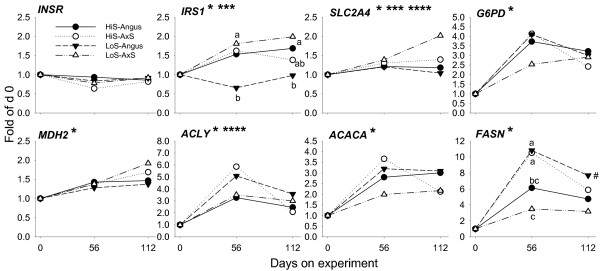
mRNA expression patterns of genes associated with insulin signaling (INSR, IRS1), insulin-stimulated glucose uptake (SLC2A4), cytosolic NADPH generation (G6PD), malate-aspartate shuttle (MDH2), cytosolic acetyl-CoA synthesis from citrate (ACLY), and de novo fatty acid synthesis (ACACA, FASN) in Angus or A × S steers (n = 6/type) fed a high-starch (HiS, n = 3/type) or low-starch (LoS, n = 3/type) diet. Fold-change expression during the growing phase is expressed relative to day 0. Pooled SEM: INSR, 0.1; IRS1, 0.2; SLC2A4, 0.2; G6PD, 0.6; MDH2, 0.2; ACLY, 0.7; ACACA, 0.5; FASN, 1.2. Asterisks denote (P < 0.05): *Time effect; **Diet effect; ***Steer type effect; ****Tendency (P < 0.13) for diet × steer type × day interaction. IRS1 and FASN had (P < 0.05) a diet × steer type interaction. FASN had (P < 0.05) a diet × steer type × day interaction. Superscripts denote differences (P < 0.05) among treatments at specific time points.